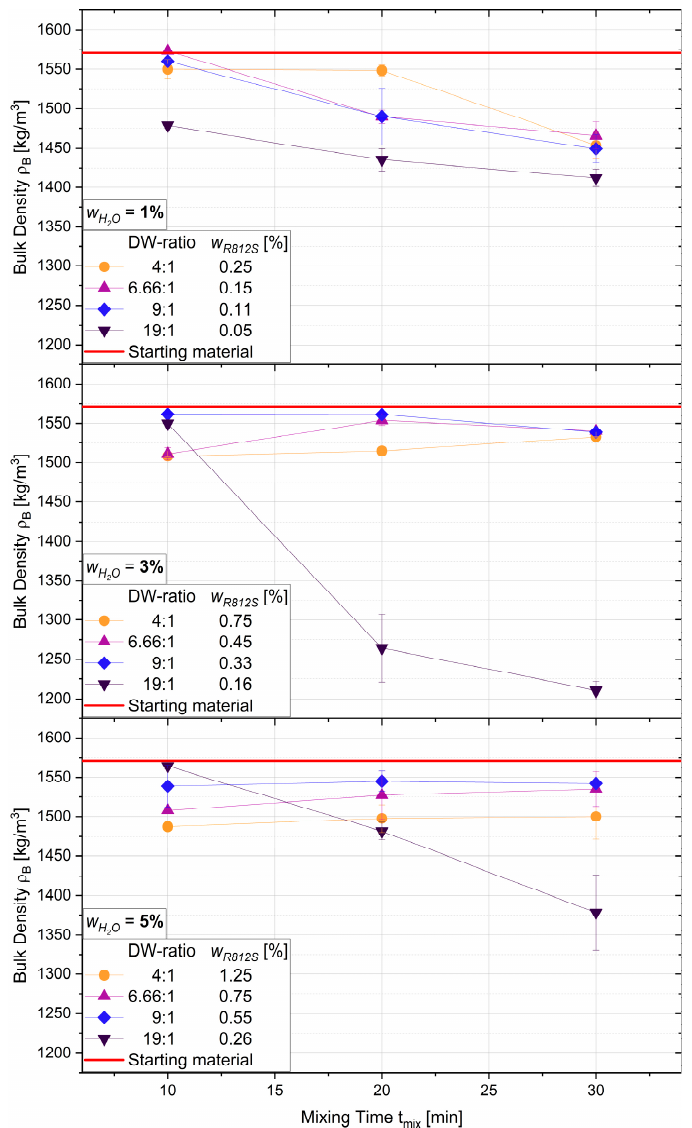
Figure 18. Bulk density in dependence of the mixing time for mixtures containing different dry water variants and total water contents: w H2O = 1% ( top ), w H2O = 3% ( centre ) and w H2O = 5% ( bottom ).